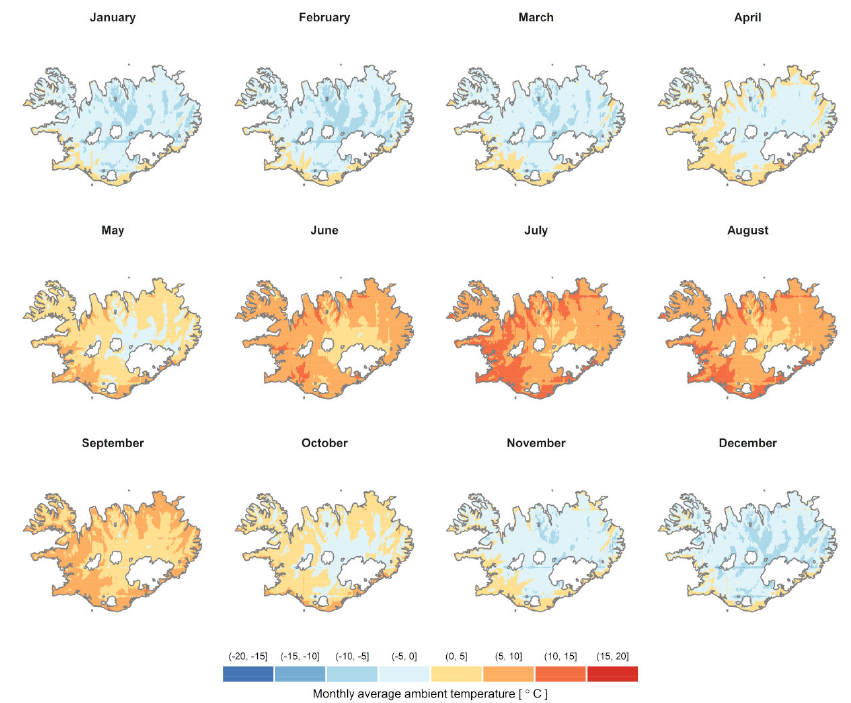
Figure A1. Monthly average daily ambient temperature maps for Iceland. Values from the ECMWF- ERA-5 dataset with a coverage period of 2005–2016 retrieved from PVGIS as a 0.05 ◦ × 0.05 ◦ grid both in latitude and longitude, extending from 63 ◦ N to 67.5 ◦ N in latitude and 13 ◦ W to 25 ◦ W in